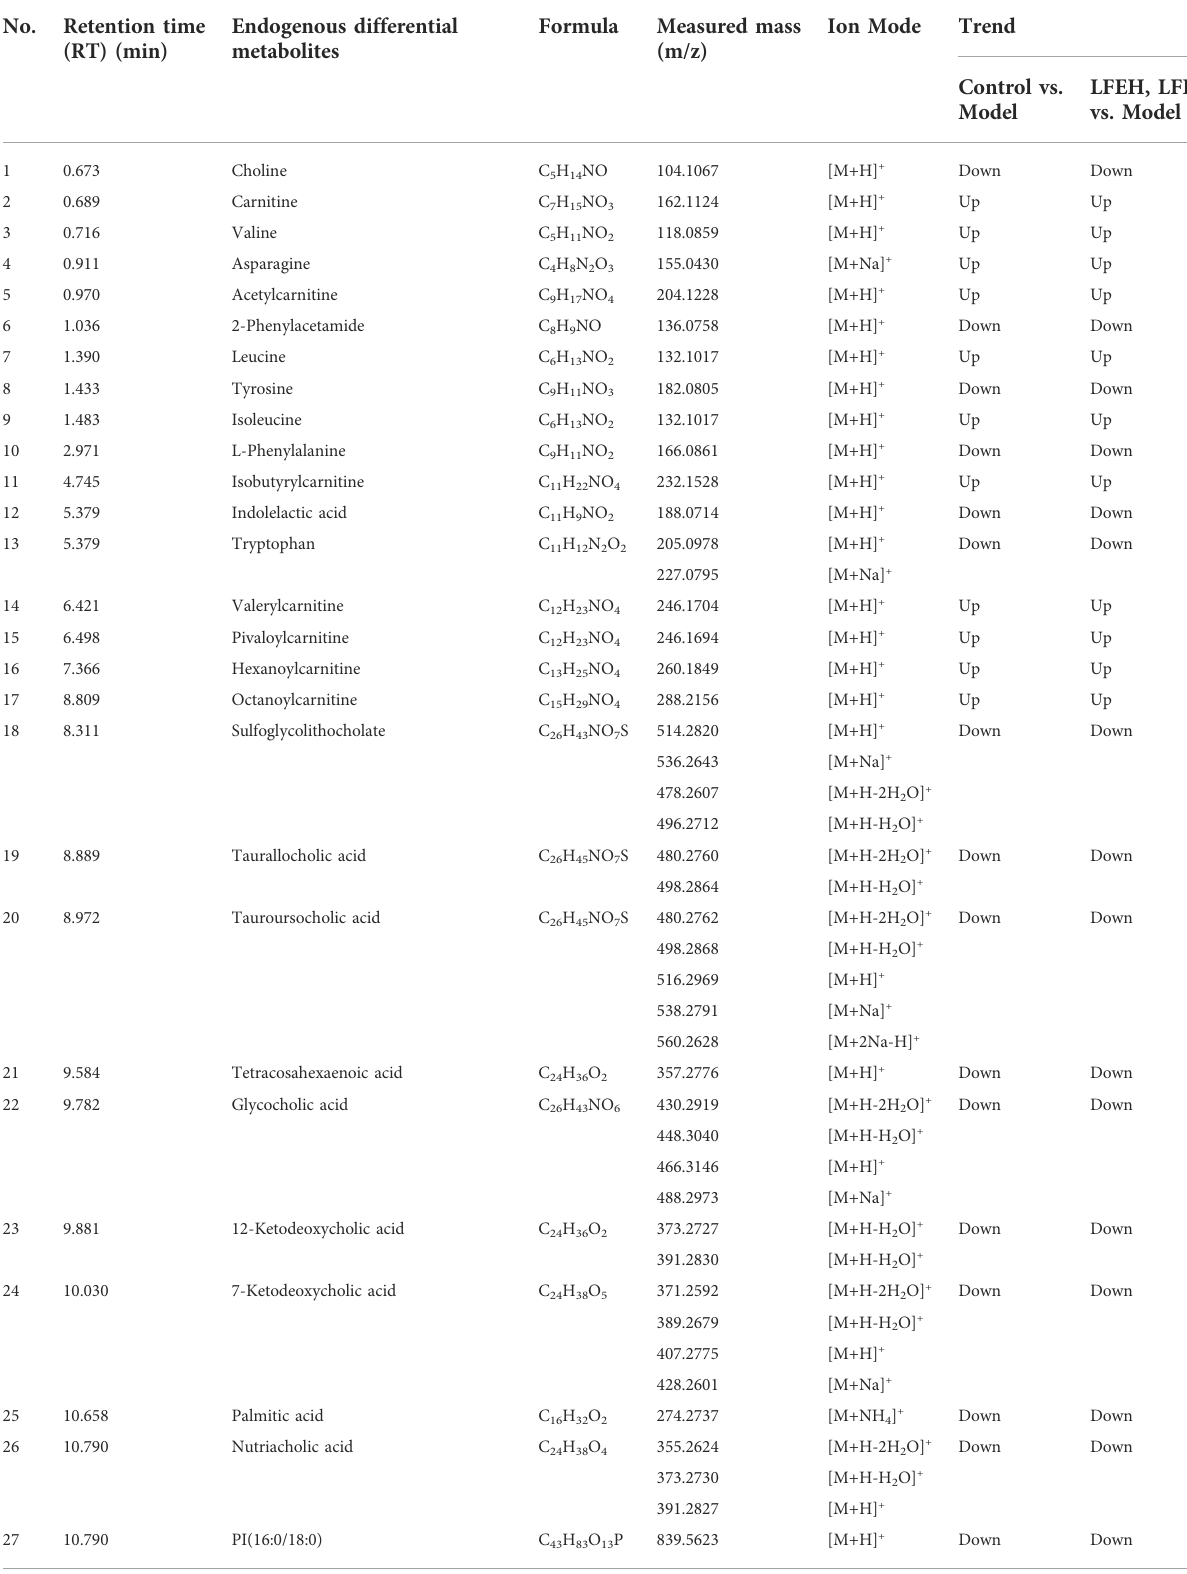
TABLE 2 Endogenous differential metabolites in positive ion mode.